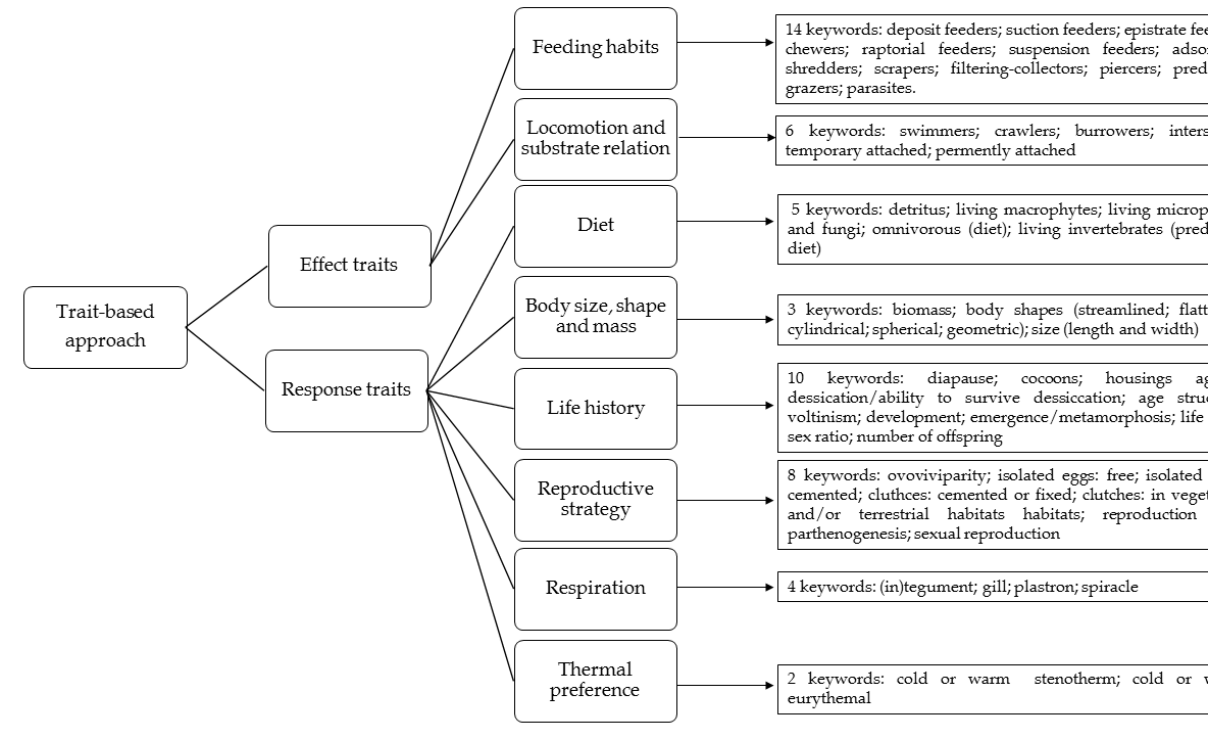
Figure 2. Framework of the trait keywords.